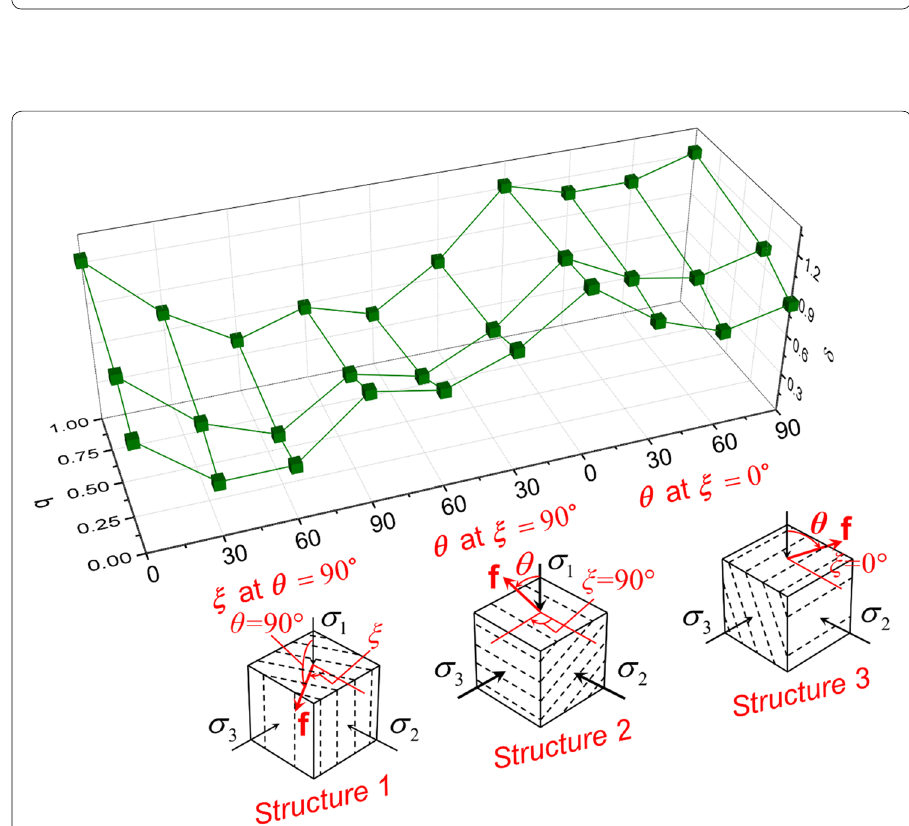
Fig. 9 The spatial angle δ of Toyoura sand as a function of b and ϑ values from Lam and Tatsuoka’s [15]